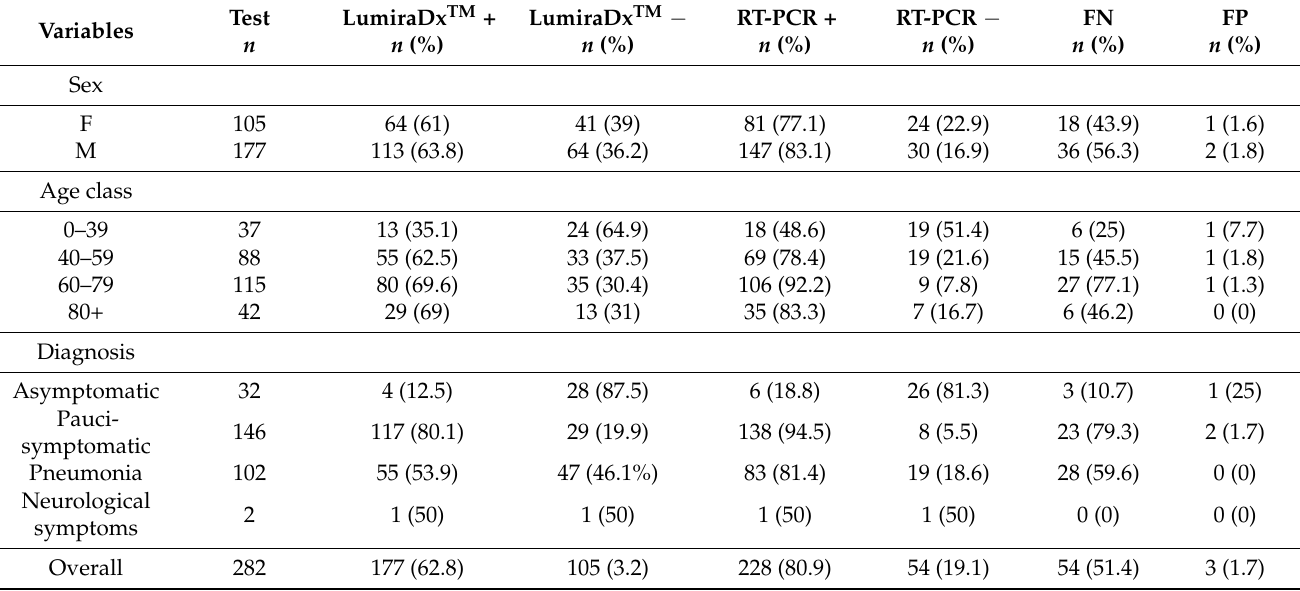
Legend to Table 1. (+): Positive; ( − ): Negative; F: Female; M: Male; FN: False negative; FP: False positive. FN: LumiraDx™ negative test in the presence of a positive real time RT-PCR test. FP: LumiraDx™ positive test in the presence of a negative real time RT-PCR test.